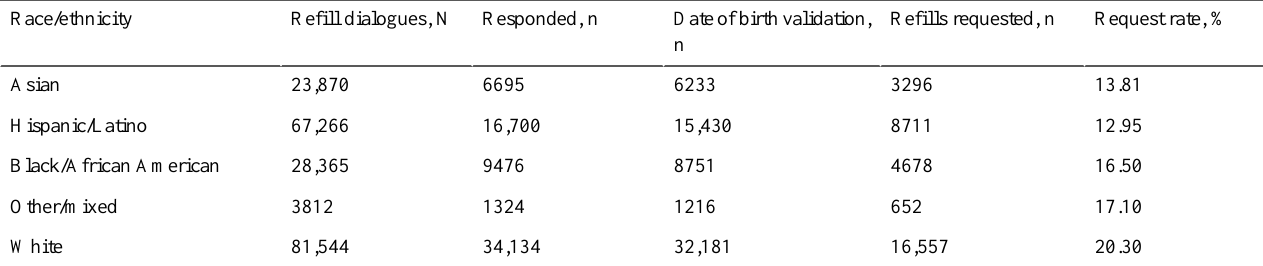
Table 5. Response and refill request rates by race/ethnicity.